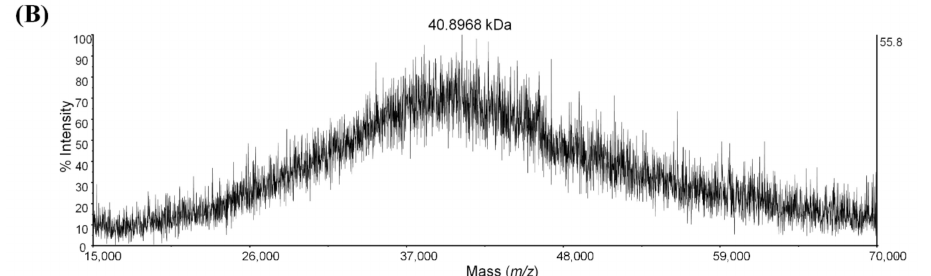
Figure 1. 1 H NMR and MALDI-TOF analysis of synthesized BHA. ( A ) The structure and the 1 H NMR spectrum of BHA. Prior to characterization, BHA was dissolved in D 2 O as a concentration of 10 mg/mL. 1 H NMR spectra of BHA were recorded at 348 K with a 500 MHz NMR spectrometer. ( B ) The mass spectrum of BHA. BHA was prepared in 2,5-dihydroxybenzoic acid with an equal volume of matrix solution. BHA: partially butylated HA; GlcA: D-glucuronic acid; GlcNAc: N -acetyl- D-glucosamine; GlcNBu: N -butyl-D-glucosamine.